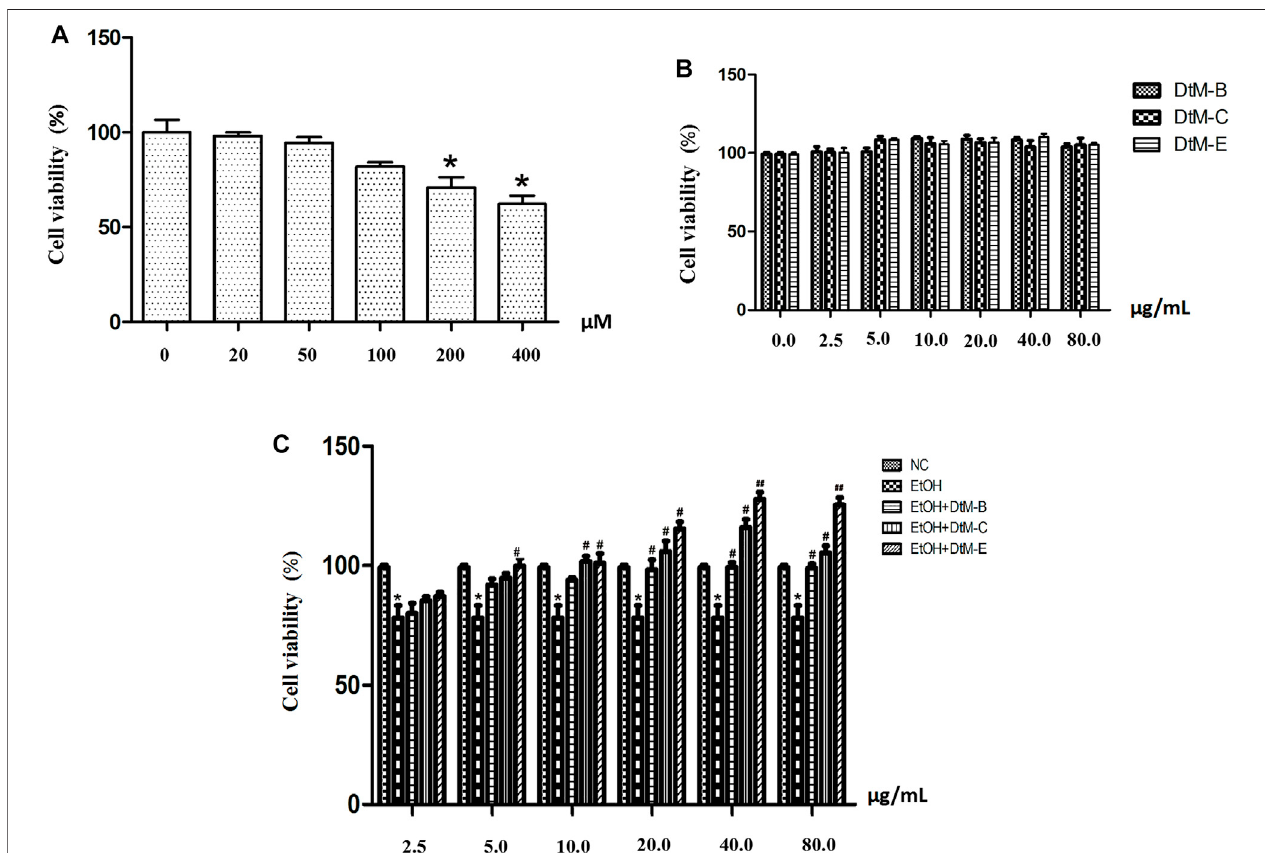
FIGURE 3 | EtOH-induced cytotoxicity at different concentrations (A) and the effect of n-butanol extract (DtM-B), chloroform extract (DtM-C), and ethyl acetate extract(DtM-E)onnormal (B) andEt-OHinduced (C) cells.Alldataarepresentedasmean ± SD( n = 6).* p < 0.05( vs .controlgroup); p < 0.05and ## p < 0.01( vs .model